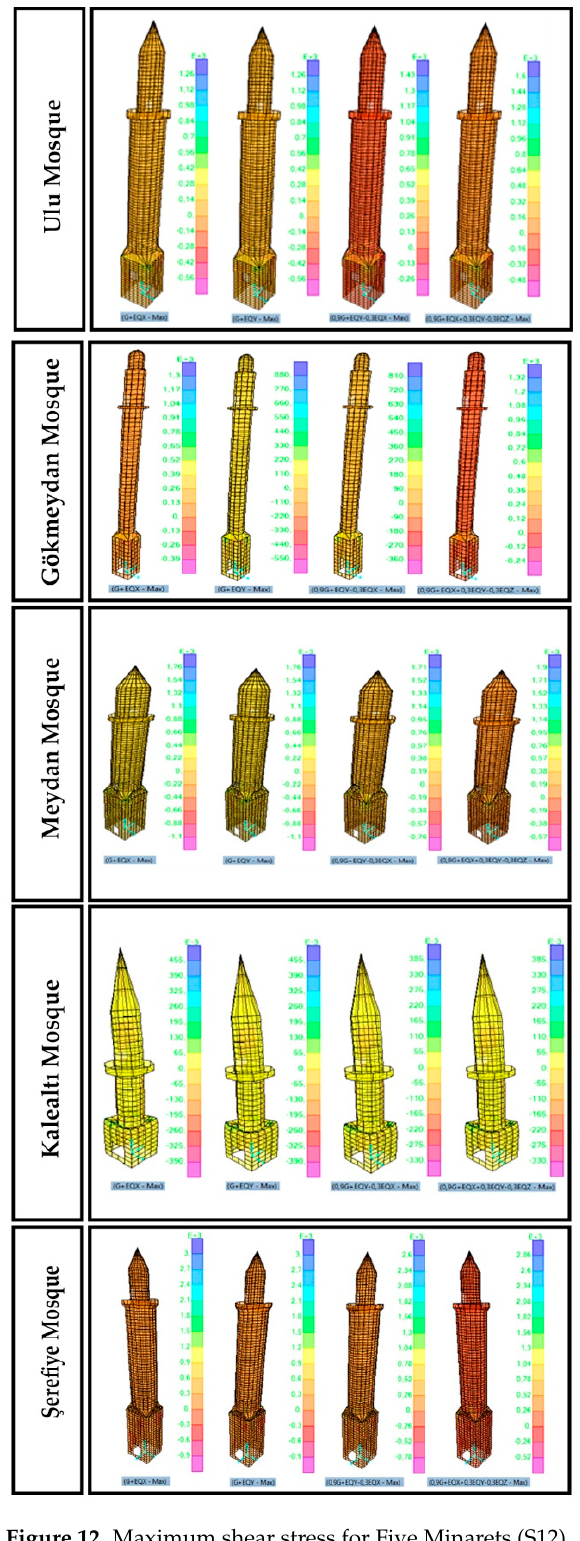
Figure 12. Maximum shear stress for Five Minarets (S12). The comparison of the maximum tensile stresses for Five Minarets according to the results of the structural analysis is given in Table 6.